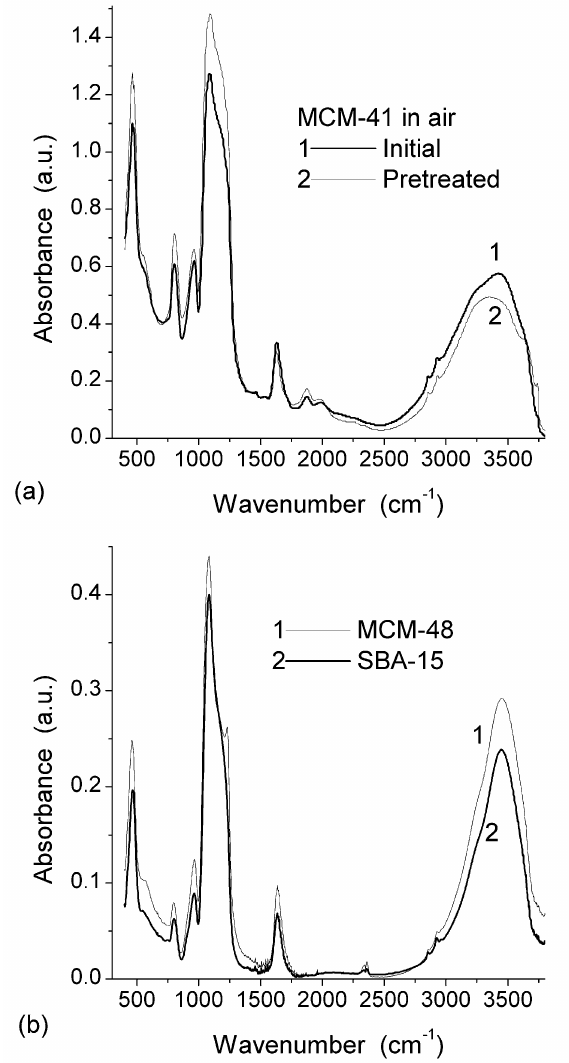
Fig. 14 FTIR spectra of (a) MCM-41 (sample 1) initial and treated in air at 473 K for 2 h, and (b) MCM-48 and